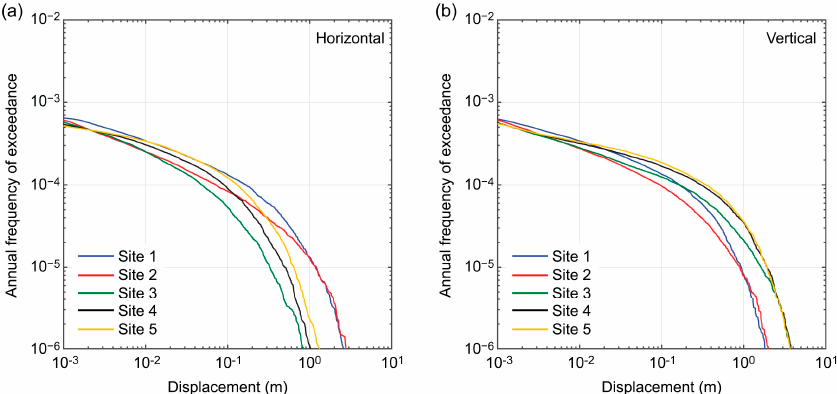
Figure 9. Fault displacement hazard curves for Sites 1 to 5: ( a ) horizontal displacement and ( b ) vertical displacement.